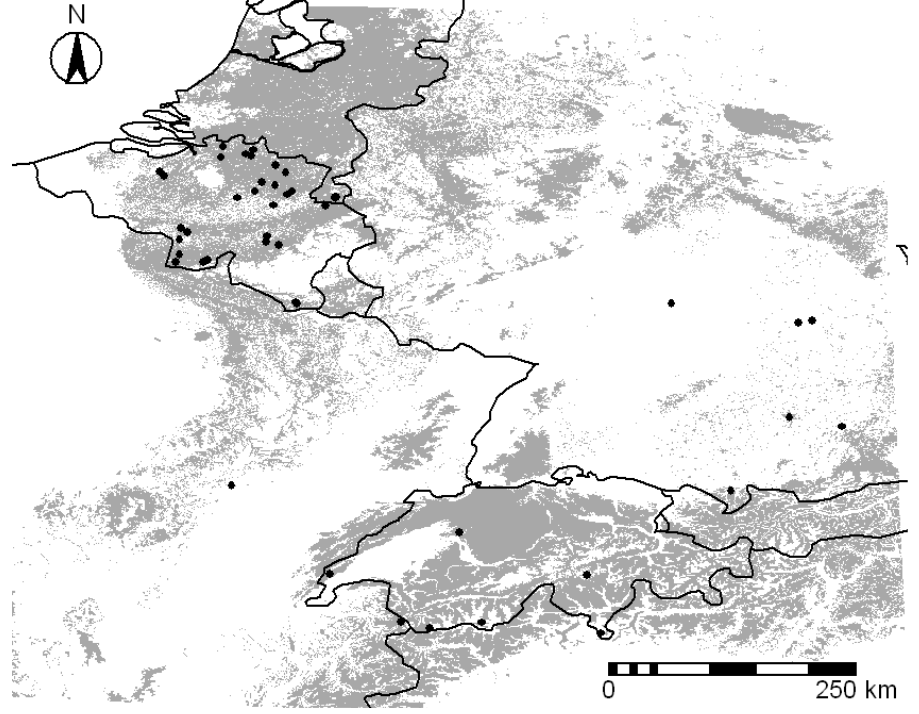
Figure 1. Map of geographical distribution of bank voles. Areas predicted to be habitable place for bank voles are indicated in grey. The dots represent the bank voles occurrence data